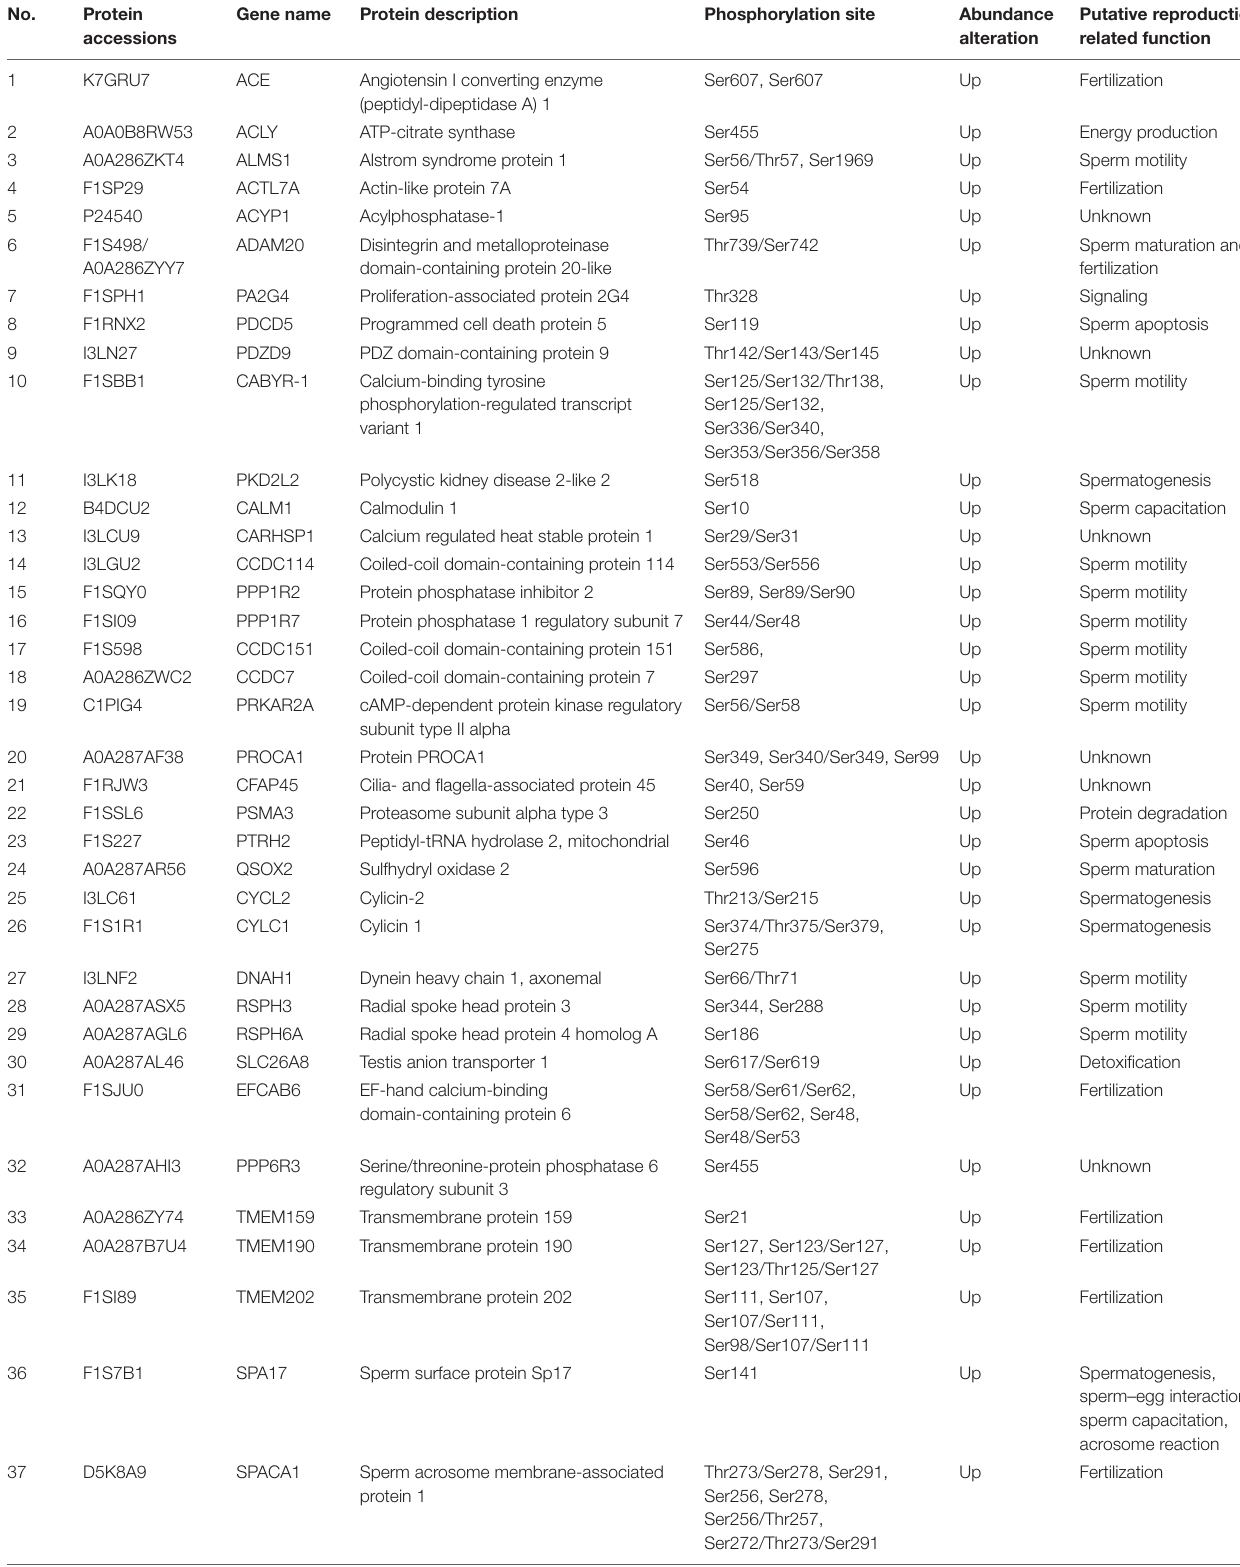
TABLE 1 | The list of the differentially expressed phosphoproteins involving the sperm fertility.